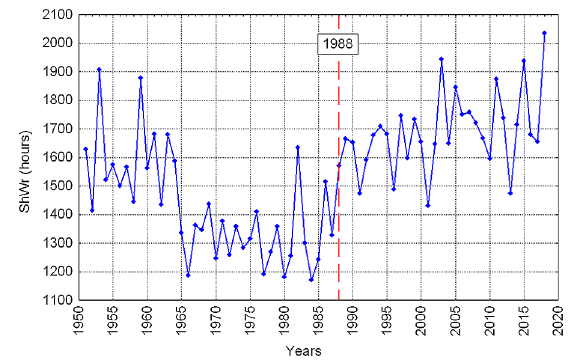
Fig. 6. The course of annual sunshine duration in Wroclaw ShWr. The vertical dashed line (1988) marks the moment of transition of significantly different courses of Table 1. Values of correlation coefficients (r) between monthly and annual cloudiness in Wrocław and air tem - perature in Wrocław (TWr) and their statistical significance (p). Analysis period: 1951–2018.